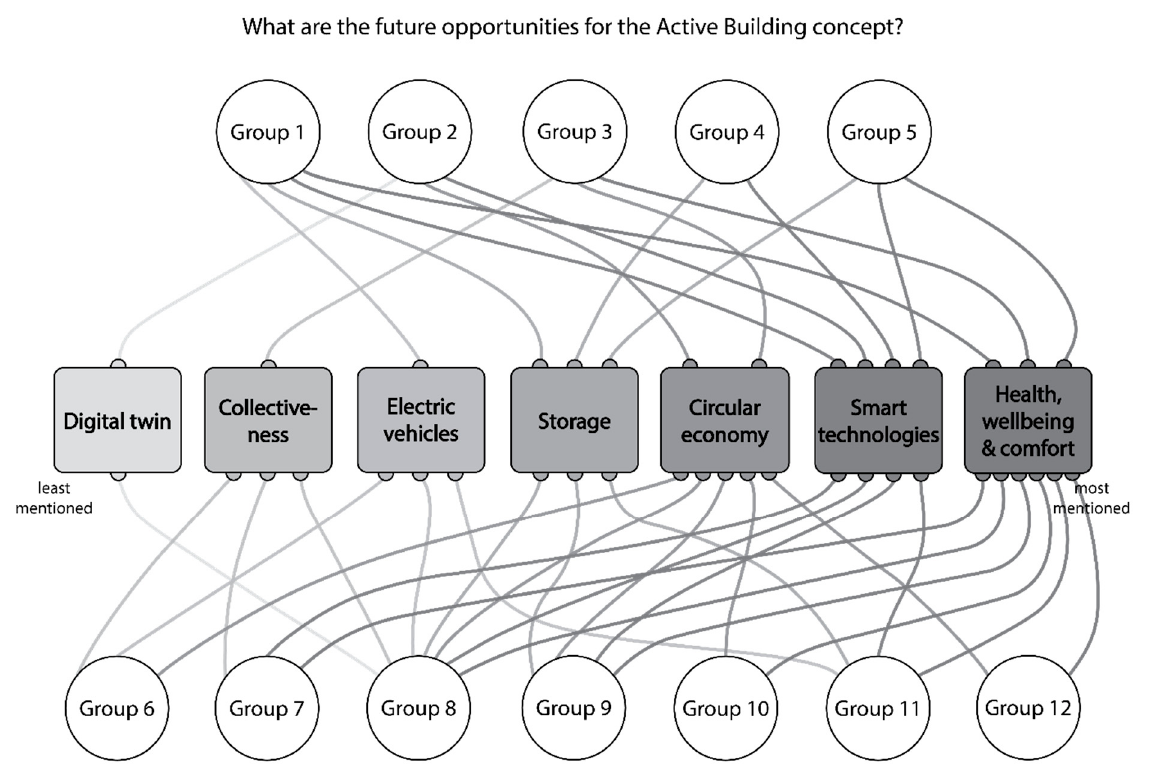
Figure 6. Future opportunities for the dissemination of active buildings according to different groups of stakeholders.